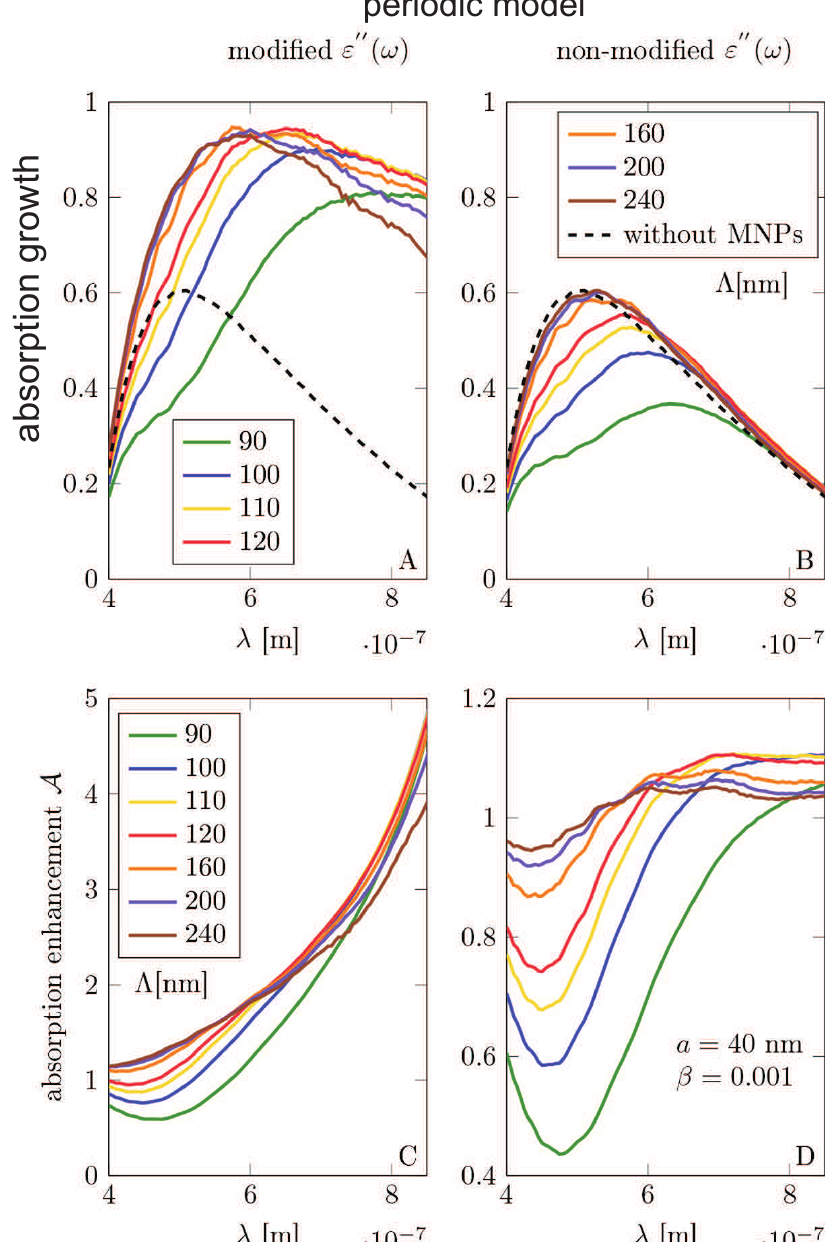
Figure 6. The periodic model—( A , B ): The absorption enhancement of the light absorption in the Si substrate as the function of the wavelength of incident electromagnetic wave for various size of the unite cell Λ . ( C , D ): The efficiency enhancement of the system acc Equation (27) as a function of the wavelength of incident electromagnetic wave. ( A , C ): results obtained in the model using the ′′ ( ω ) by plasmon damping contribution (the energy modified dielectric function of the semiconductor ε leaving plasmons incomes to the semiconductor substrate); ( B , D ): results obtained in the model using non-modified dielectric function of the semiconductor measured in bulk [42]. The calculations was made for MNPs of radii a = 40 nm and for the array period Λ = 90, 100, 110, 120, 160, 200, 240 nm describing the lowering of the nanoparticle